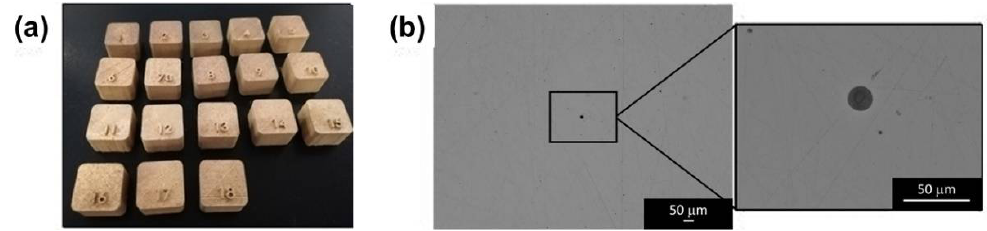
Figure 2. ( a ) Picture of the Cu-10Sn samples produced by LPBF with the DoE. ( b ) OM images of Cu-10Sn samples for density measurements at lower ( left ) and higher ( right ) magnification. Only a very small spherical pore could be detected.